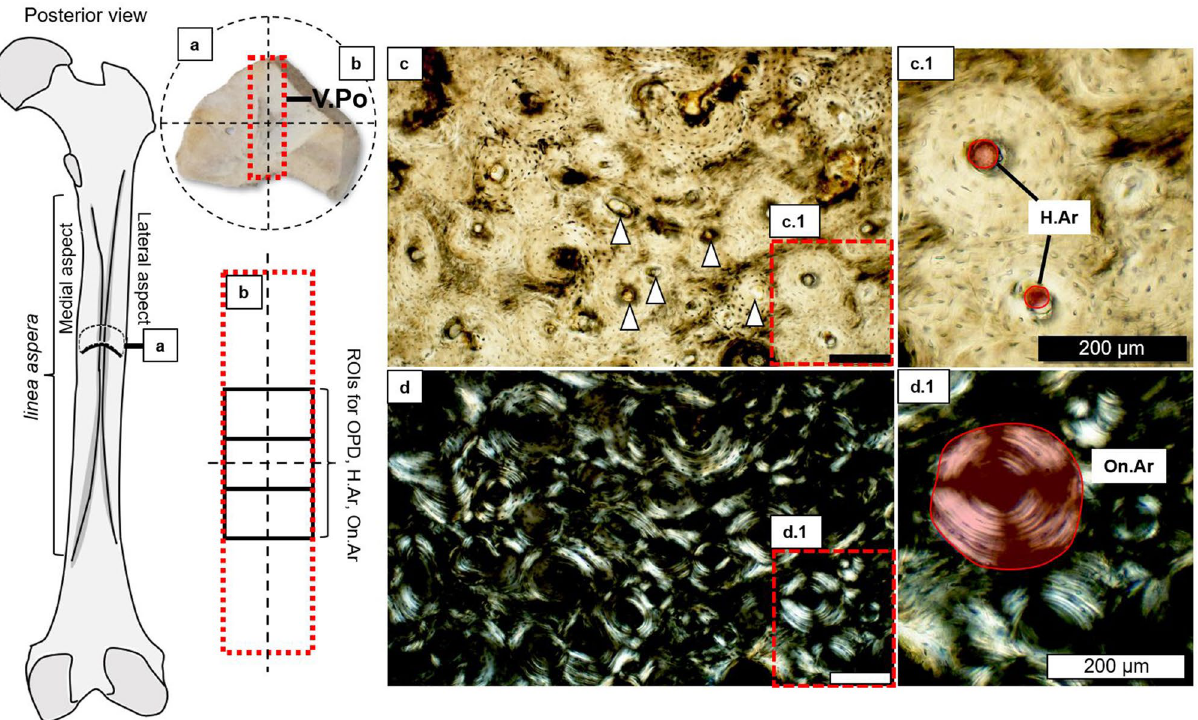
Figure 2. Summary of histomorphometric techniques used in this study. From left sketch of right posterior human femur: ( a ) posterior cortical bone quadrant showing a strip (red dashed lines) of bone surface examined histologically from which vascular porosity (V.Po) was collected; ( b ) three intra-cortical regions of interest (black rectangles) contained within the larger strip examined for osteon population density (OPD), Haversian canal area (H.Ar), and secondary osteon area (On.Ar); ( c ) bone histology under transmitted light showing Haversian canals counted for V.Po (white triangle markers) and measured for area ( c.1 ); ( d ) bone histology under linearly polarised light showing secondary osteon area ( d.1 ). Scale bars in ( c , d ) are 200